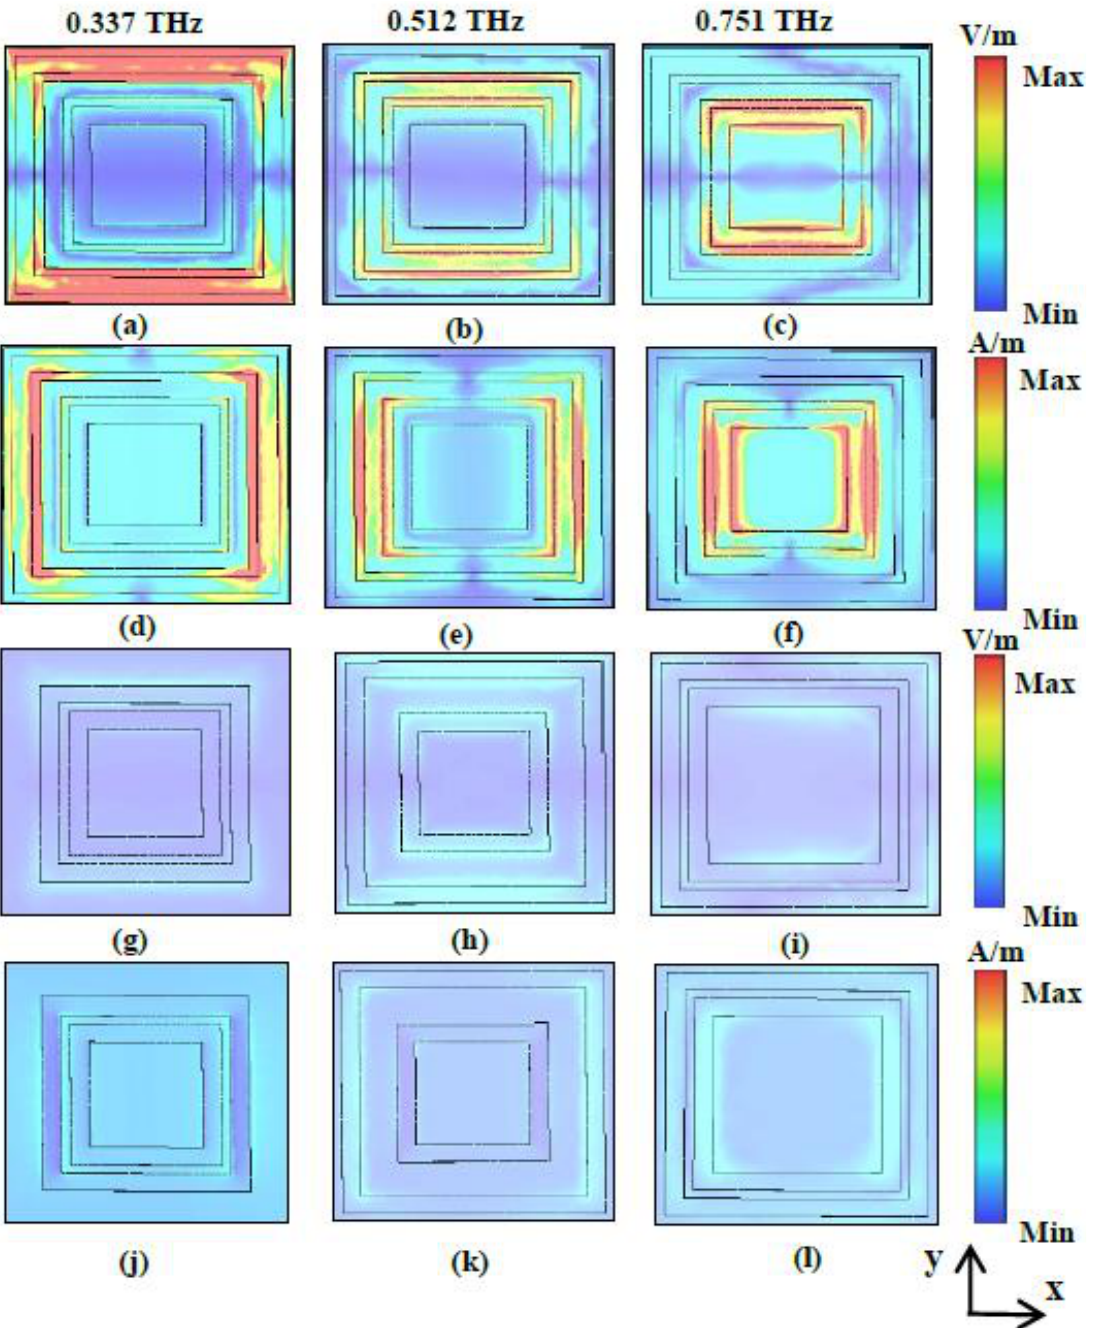
Figure 5. Electric field distributions in x – y plane of the unit cell at resonance frequencies of ( a ) 0.337 THz; ( b ) 0.496 THz; ( c ) 0.718 THz and magnetic field distributions in x – y plane of the unit cell at resonance frequencies of ( d ) 0.337 THz; ( e ) 0.496 THz; ( f ) 0.718 THz; electric field distributions in x – y plane of the unit cell in the case of three combinations of configurations with two rings (middle + inner, outer + inner, outer + middle) at the resonance frequencies ( g ) 0.337; ( h ) 0.496; ( i ) 0.718 THz and magnetic field distributions in x – y plane of the unit cell at the resonance frequencies ( j ) 0.337; ( k ) 0.496; ( l ) 0.718 THz.